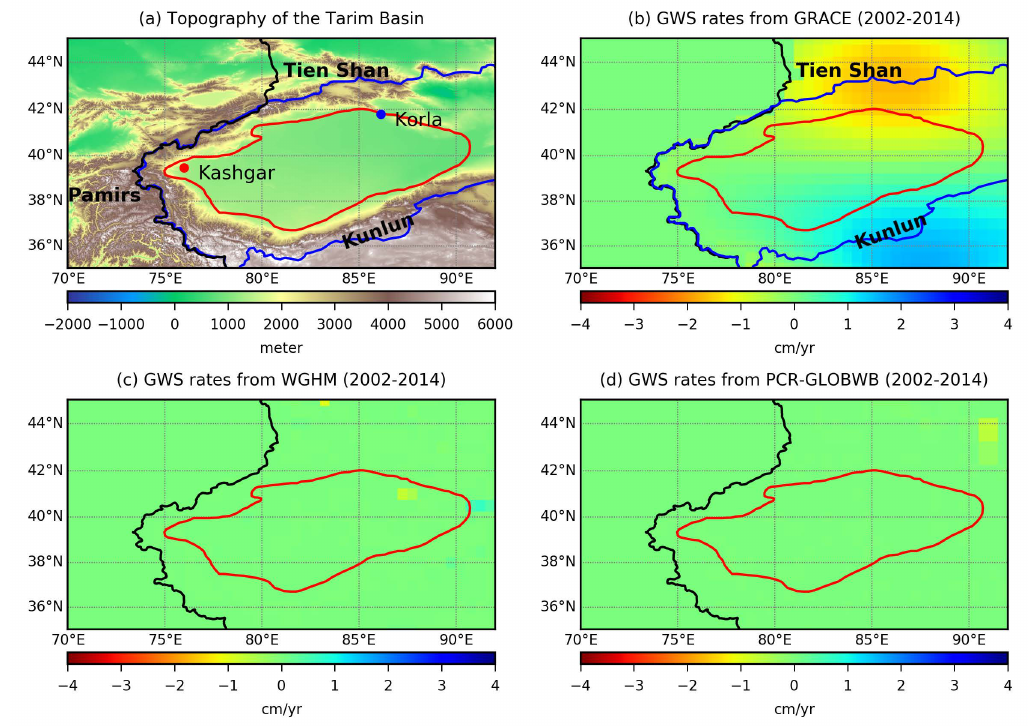
Figure 9. ( a ) Topography of the TRB and its surroundings. The red boundary outlines the plain region of TRB. The blue line shows the boundary of the TRB, same as Figure 1. Locations of two cities where well observations are available, i.e., Korla and Kashgar, are also shown. GWS rates from ( b ) GRACE, ( c ) WGHM and ( d ) PCR-GLOBWB in the TRB and its surroundings during